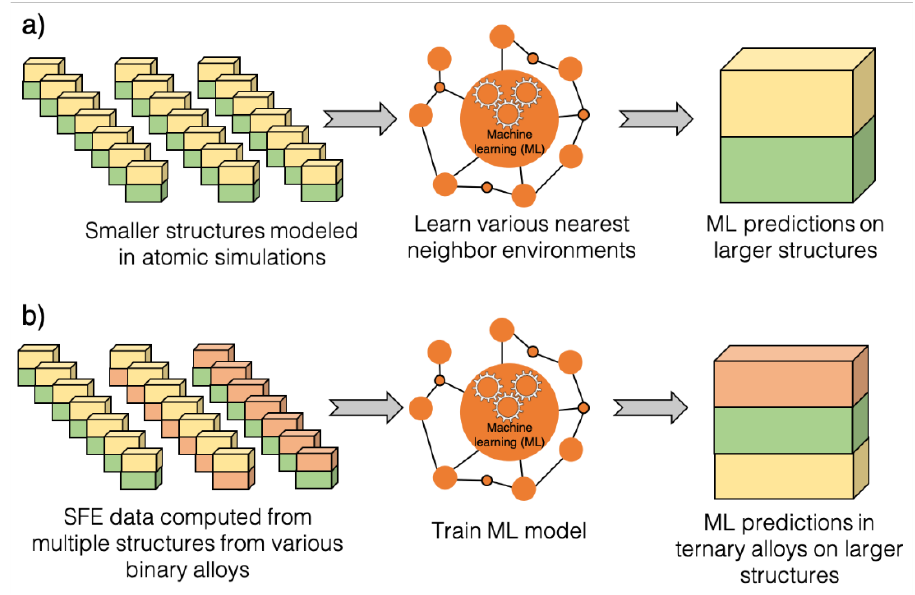
Figure 1. Schematic representation of the methodology used to train and predict SFE (stacking fault energy) using ML (machine learning). ( a ) The SFE and the nearest neighbor information is extracted from smaller supercells, which is used to train ML model to predict SFE of larger supercells. ( b ) SFE and the nearest neighbor information is extracted from various binary alloys, which is used to train ML model to predict SFE of ternary alloys.